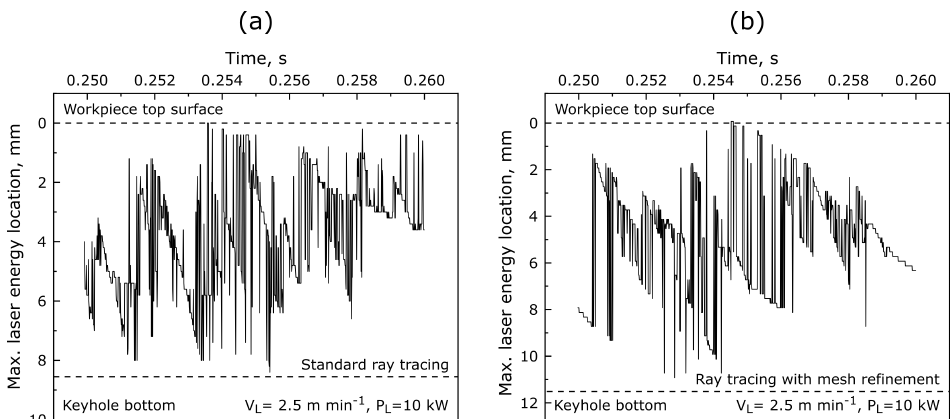
Figure 9. Temporal distribution of the maximum laser energy location calculated with the ( a ) standard and ( b ) virtually refined ray tracing